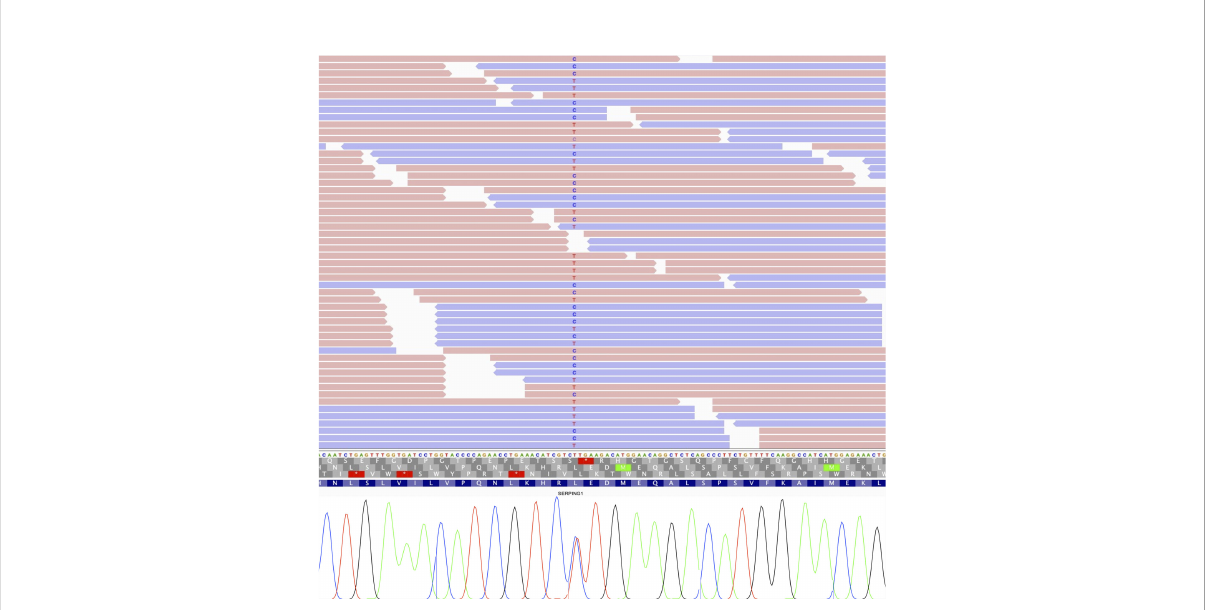
FIGURE 3 IGV view of sequencing reads supporting each allele of SERPING1 variant (up), and Sanger sequencing validation showing both alleles